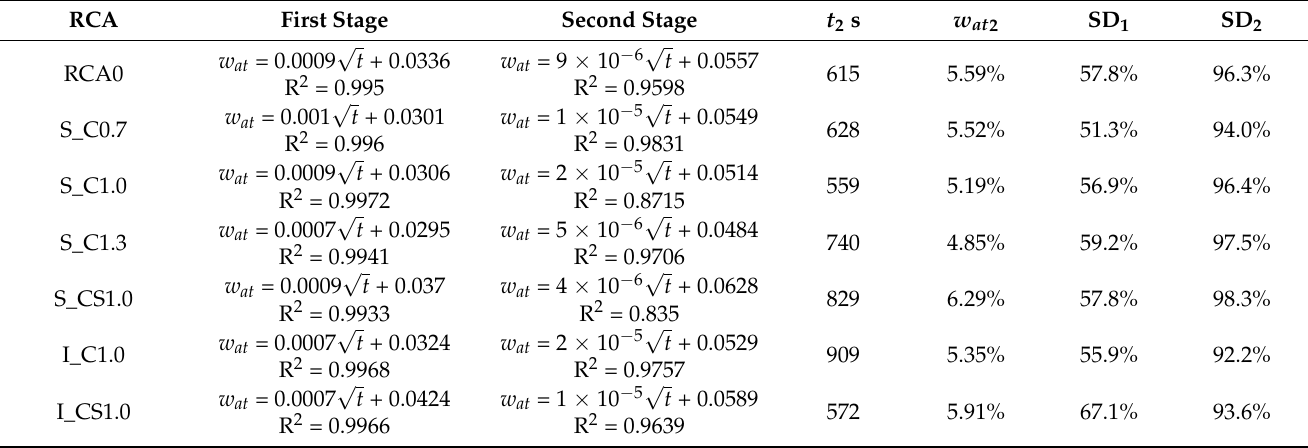
Table 5. Functions and key parameters of the two-stage model of the RCA.